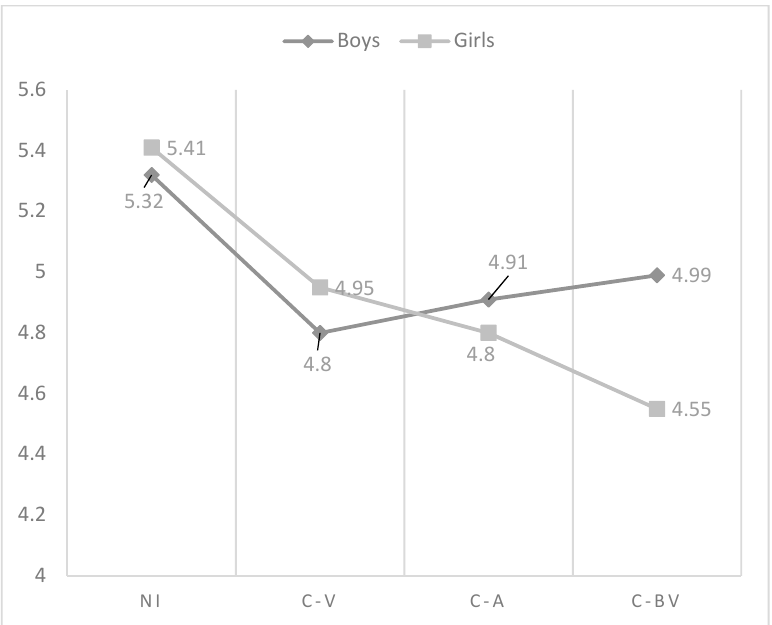
Figure 1. Effect of the interaction of gender and cyberbullying roles on mother affection and communication. Notes: NI = Non-involved; C-V = Cyber-victim; C-A = Cyber-Aggressor; C-BV = Cyber-bully/victim.